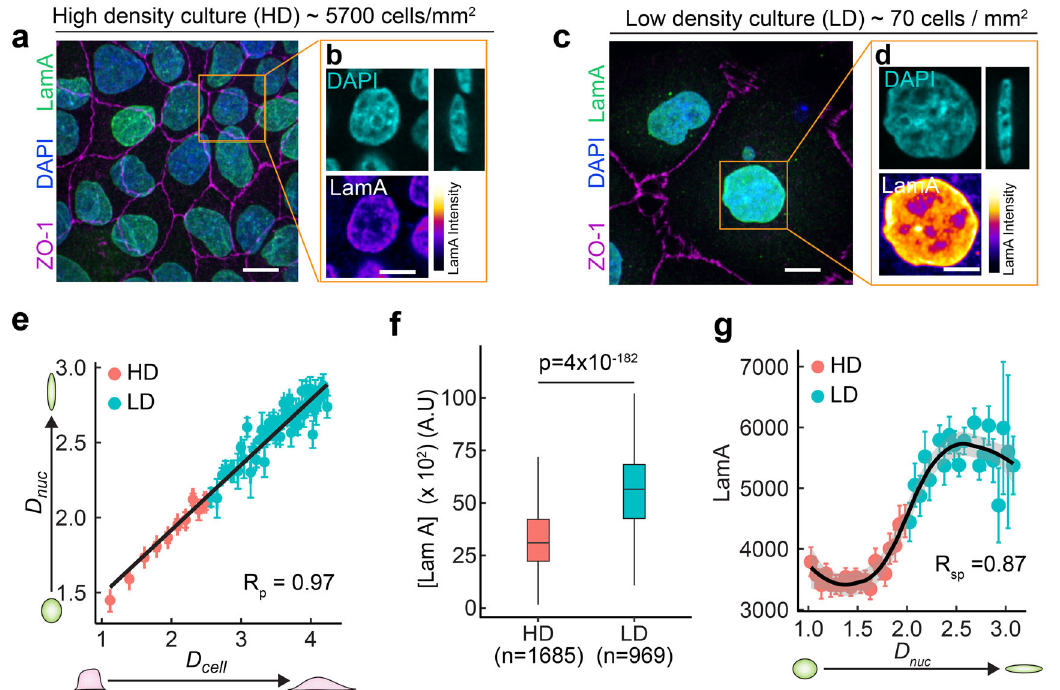
Fig. 6 Regulation of Lamin A/C by apico-basal cell compression is also observed in mammalian epithelial cells. a Image showing high-density culture of 5700 cells/mm 2 . Tight junction protein ZO-1 is shown in magenta, Lamin A in green, and DAPI in blue. Scalebar, 15 µ m. b Enlarged images of the region shown by the orange ROI in ( h ). DAPI is shown in blue and Lamin A is shown in color-coded intensity. Scale bar, 10 µ m. c Image showing low density culture of 70 cells/ mm 2 . Tight junction protein ZO-1 is shown in magenta, Lamin A in green, and DAPI in blue. Scalebar, 15 µ m. d Enlarged images of the region shown by orange ROI in ( j ). DAPI is shown in blue, and Lamin A is shown in color-coded intensity. Scale bar, 10 µ m. e Binned scatter plot between D D D D D cell and nuc generated by binning cell in bins of 0.07. Each point in the plot represents mean value of cell and nuc in the bin. The red points represent data from HD culture and cyan points represent data from LD culture. The data are presented as mean ± S.E.M. Solid red line represents the linear regression to the data. Pearson ’ s correlation coef fi cient R p is 0.97. f Box-plot showing LamA in high density (HD) and low density (LD) cultures. The sample number, n represents the number of cells analyzed over 3 independent biological replicates. g Binned scatter plot between D nuc and LamA intensity generated by binning D nuc in bins of 0.06. Each point in the plot represents mean value of D nuc and LamA in the bin. The red points represent data from HD culture and cyan points represent data from LD culture. The data are presented as mean ± S.E.M. Solid black line represents the LOESS regression to the data. Spearman ’ s rank correlation coef fi cient R sp is 0.87 In the box-plot, horizontal line represents the median of the data, lower and upper bounds of the box represent the 25th and 75th percentile of data, and the whiskers represent the minimum and maximum of the data. The scattered point on the box represents the actual data points. p values are estimated by two-sided Student ’ s t -test and the p values are indicated in the respective plots.